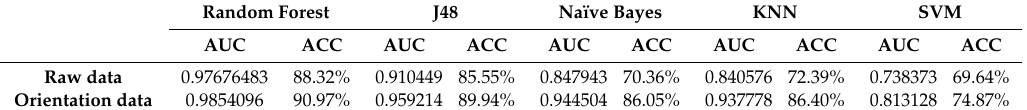
Table 11. The result between Raw data and Orientated data using TFH2 feature set with the window size of 5 s at 50% overlapping.